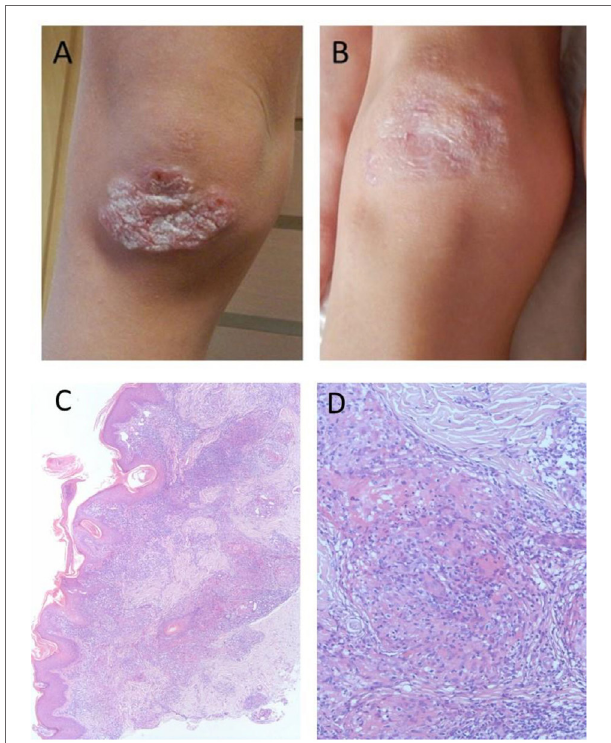
FigUre 1 | Macroscopic and microscopic images of granulomatous lesion in a boy with Nijmegen Breakage Syndrome: (a) at referral, after multiple courses of antibiotics and topical steroids, (B) after conditioning for hematopoietic stem cell transplantation, (c) skin histology demonstrating perivascular and diffuse, mixed-cell infiltrate in superficial and deep dermis. H&E stain, 40 × magnification, (D) skin histology demonstrating palisaded inflammatory infiltrates consisting of histocytes, lymphocytes, and neutrophils, associated with basophilic alterations of collagen. H&E stain, 400 ×